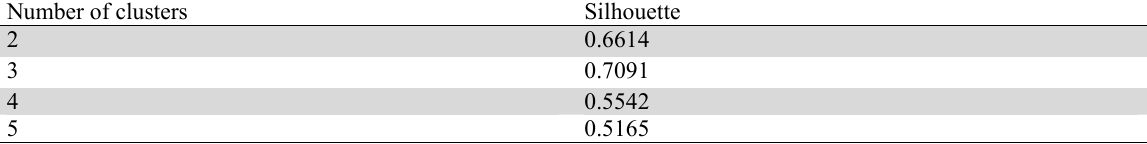
Comparing silhouette values of K-means algorithm for customer loyalty Number of clusters